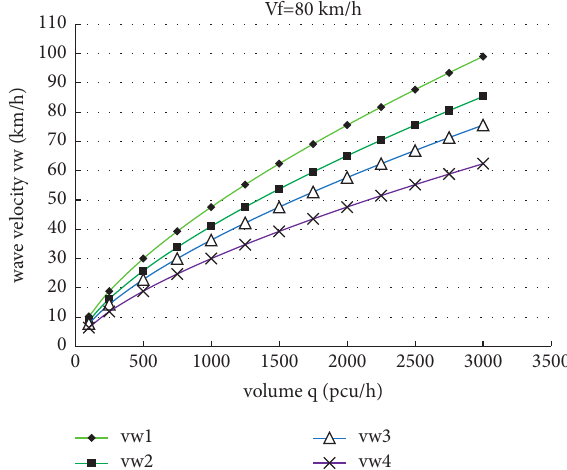
Figure 9: v � 80, the relationship between critical velocity v f flow q under different block densities.